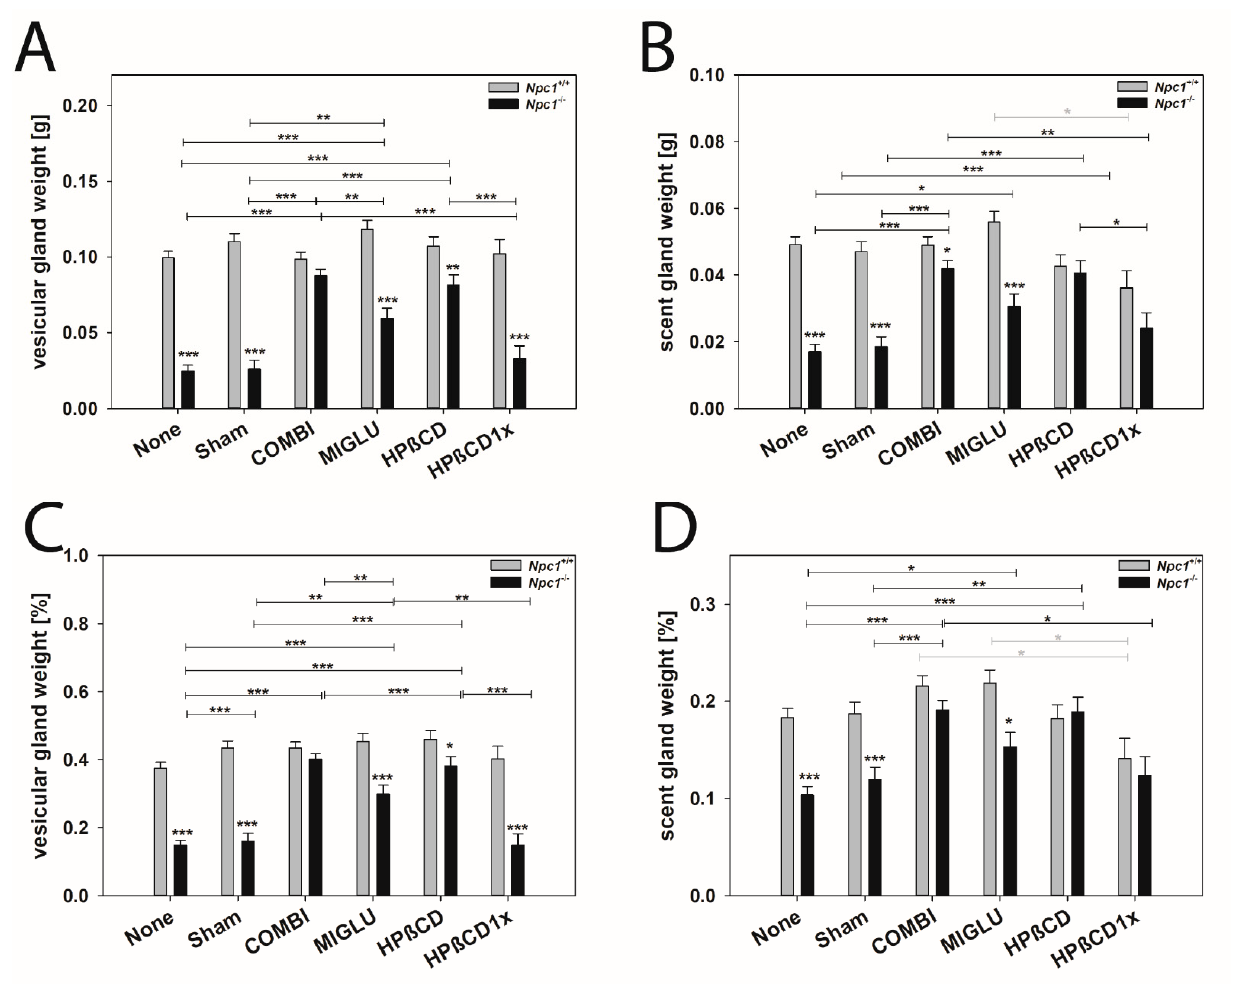
Figure 10. Vesicular gland weight ( A ) and scent gland weight ( B ), relative vesicular gland weight ( C ), and relative scent gland weight ( D ) of Npc1 mice. Significant post-hoc tests are indicated by asterisks (* p < 0.05, ** p < 0.01, *** p < 0.001). Data are means ± SEM. Nearly identical differences between experimental groups were observed in relative vesicular gland weights of Npc1 +/+ and Npc1 − / − mice (Figure 10C). The scent gland weights of the Npc1 +/+ mice of groups None (0.0491 ± 0.0024 g) and